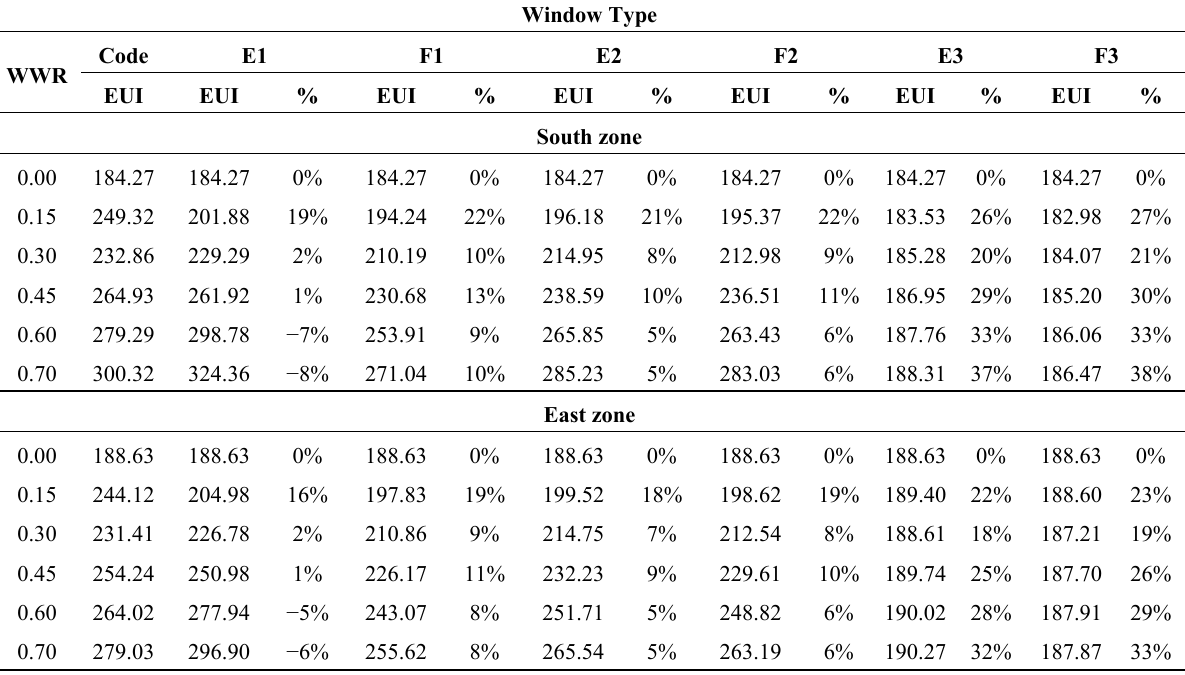
Table 12. HVAC electricity energy use intensity (EUI, MJ/m 2 -year) and percent savings compared to the GB 50189-2005 Standard for